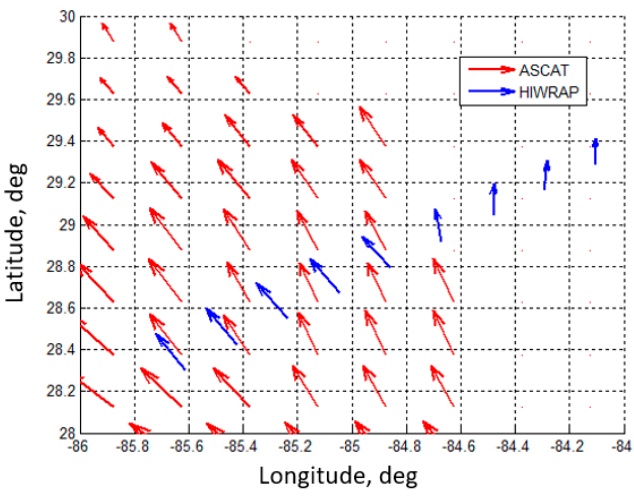
Figure 7. ASCAT 25 km resolution (red) and HIWRAP 12.5 km resolution (blue) wind vectors.